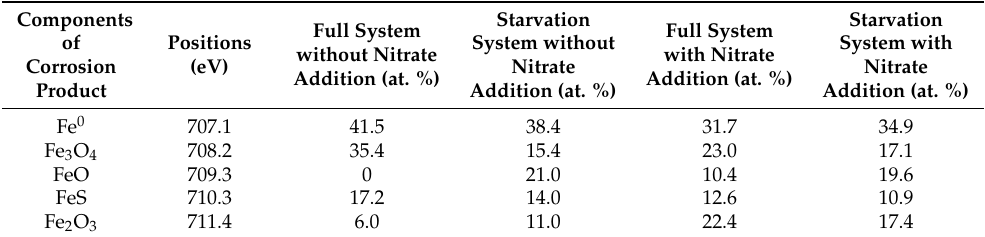
Figure 7. Fe 2p 3/2 spectra of corrosion products on EH40 steel after 14 days of immersion in different systems: ( a ) full system without nitrate addition; ( b ) starvation system without nitrate addition; ( c ) full system with nitrate addition; and ( d ) starvation system with nitrate addition. Table 2. Relative contents of components in corrosion products of EH40 steel after 14 days of immersion in different systems.